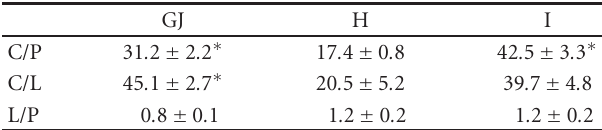
Table 3: Carbohydratase/total protease (C/P), carbohydratase/li- pase (C/L), and lipase/total protease (L/P) ratios in the gastric juice (GJ), hepatopancreas (H), and intestine (I) of juvenile Cherax albidus . Data are reported as means ± SEM. Asterisks indicate statisticallysignificantdi ff erences ( P < . 05) alongthe digestive tract within each